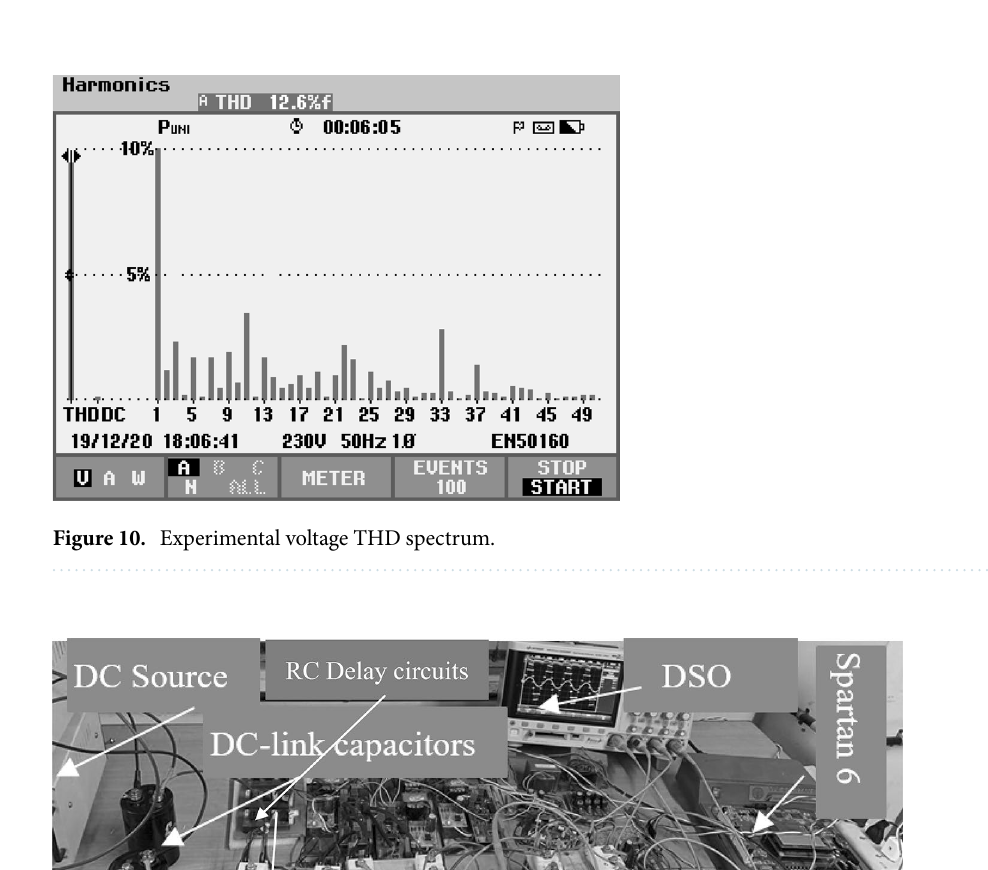
Table 6. THD comparison of various modulation techniques for switching frequency of 2.5 kHz.